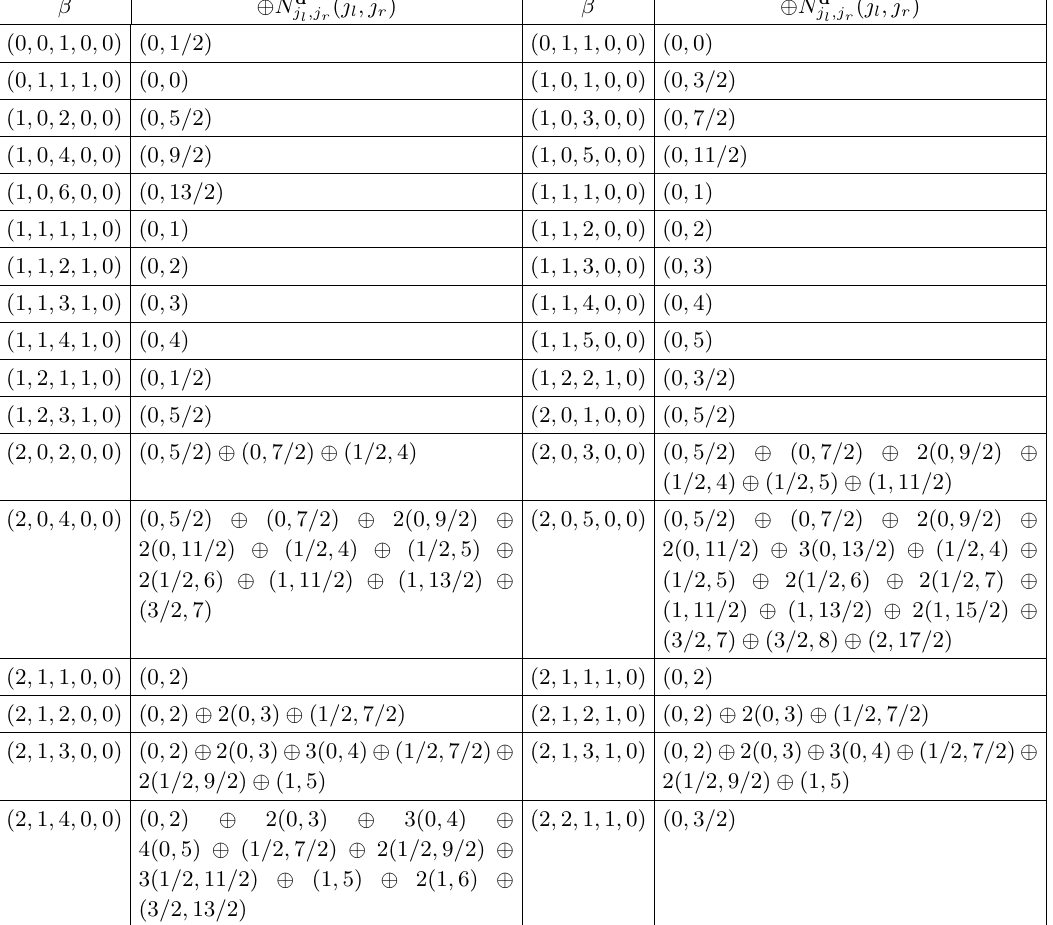
Table 20 . Refined BPS invariants of 6d n = 1 , G 2 model, with a su (2) mass turned on.